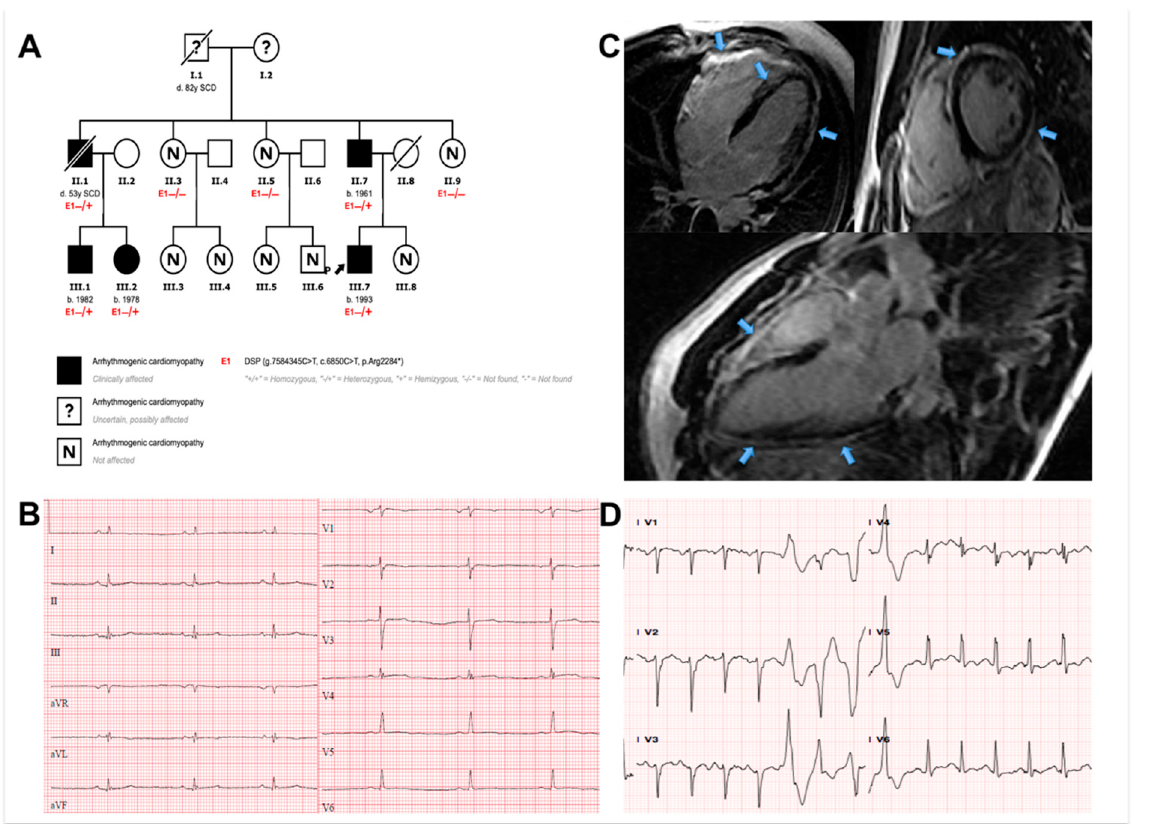
Figure A1. Example of cardiac phenotype of included patients. ( A ): Pedigree of family according to the carrier status of the p.Arg2284* desmoplakin gene variant. Males and females are marked with squares and circles, respectively. Mutation carriers are marked with (E1-/+) and non-carriers with (E1-/-). Deceased individuals are annotated by a slash. Proband is indicated with black arrow. ( B ) and ( C ): classic ECG and CMR abnormalities for DSP gene carriers are illustrated (cases III-2 and III-7, respectively). The ECG (B) is characterized by low voltages and inverted/flattened T-waves. CMR demonstrates extensive circumferential subepicardial late gadolinium enhancement ( C ). ( D ): Non-sustained ventricular tachycardia (case III.2) during cardiopulmonary exercise testing.